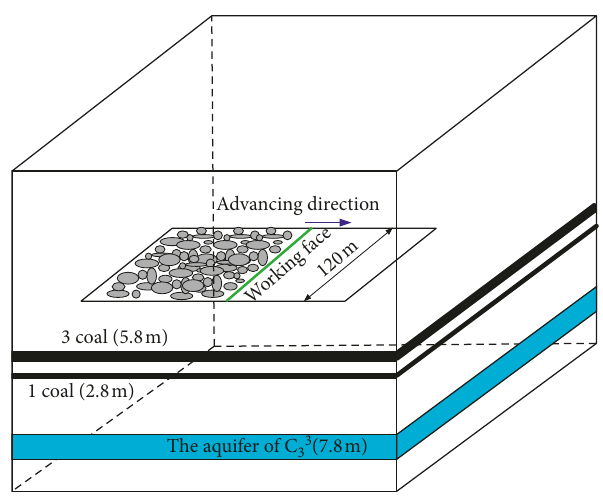
Figure 10: Working face